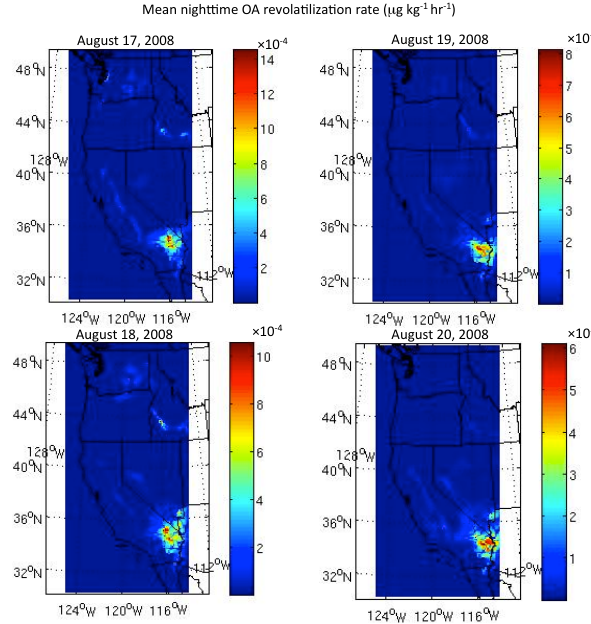
Fig. 9. Several individual night’s averages of the NO 3 -initiated OA loss, showing spatial and magnitude variability for the western United States domain.